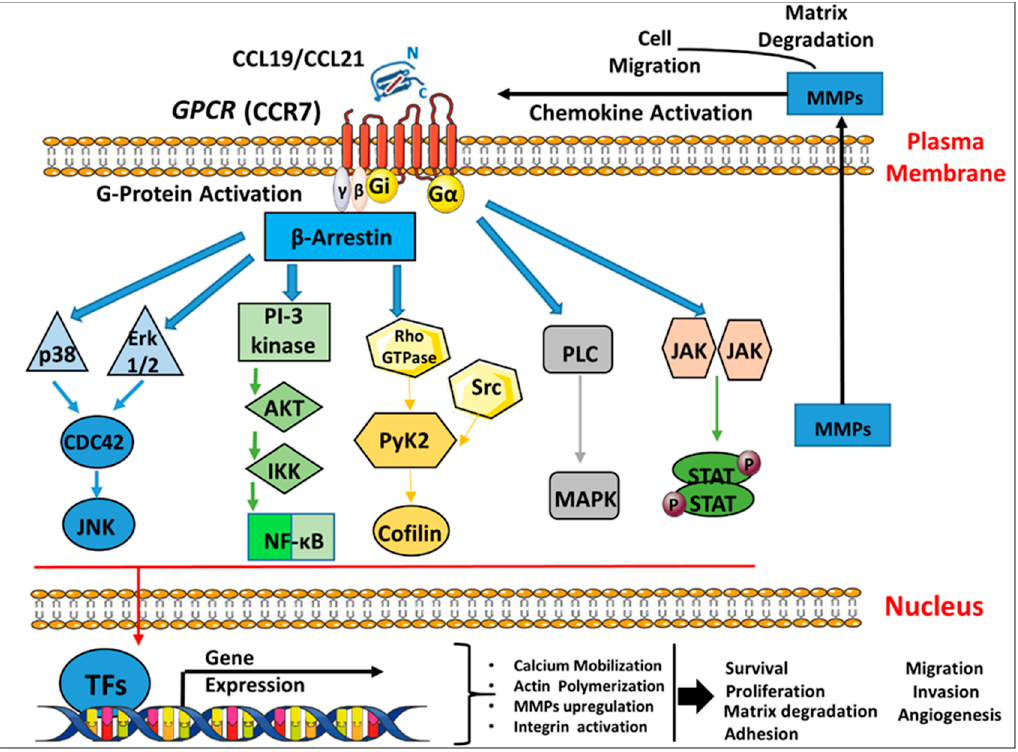
Figure 2. CCR7 chemokine receptor binding to the cognate ligands CCL19 / CCL21 inducing signaling transduction pathways in breast cancer. Schematic representation of the seven transmembrane G-protein coupled receptor (CCR7) activation and internalization by ligand binding which triggers several signaling pathways cascades as follows: a. The binding of chemokine ligands CCL19 / CCL21 to their CCR7 GPCRs leads to the activation of a G- α subunit and a Gi- βγ heterodimer. b. This initiates downstream signaling e ff ectors that further lead to signaling cascades, such as the activation of ERK1 / 2, PI3K / AKT, Rho GTPases, MAPK, and JAK / STAT, which can promote the transcription and expression of di ff erent genes such as MMPs. c. All the above induce broad biological e ff ects including chemotaxis, cell survival / proliferation, matrix degradation, reorganization of the actin cytoskeleton, adhesion, cell migration, invasion and angiogenesis. GPCR, G-protein-coupled receptors; ERK, extracellular signal-regulated kinase; JNK: c-Jun N-terminal kinase; PI3K, Phosphatidyl inositide-3-kinase; AKT, protein kinase B; NF- κ B, nuclear factor- κ B; Rho, Ras homolog gene family; PLC, phospholipase C; MAPK, mitogen-activated proteins kinase; JAK, Janus-activated kinase; TFs: Transcription factors, MMP, matrix metalloproteinase.